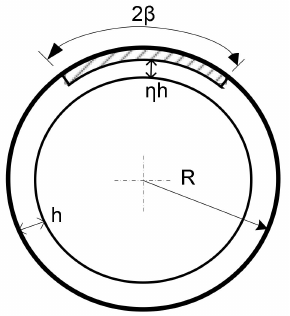
Figure 2. Geometry of circumferential crack.